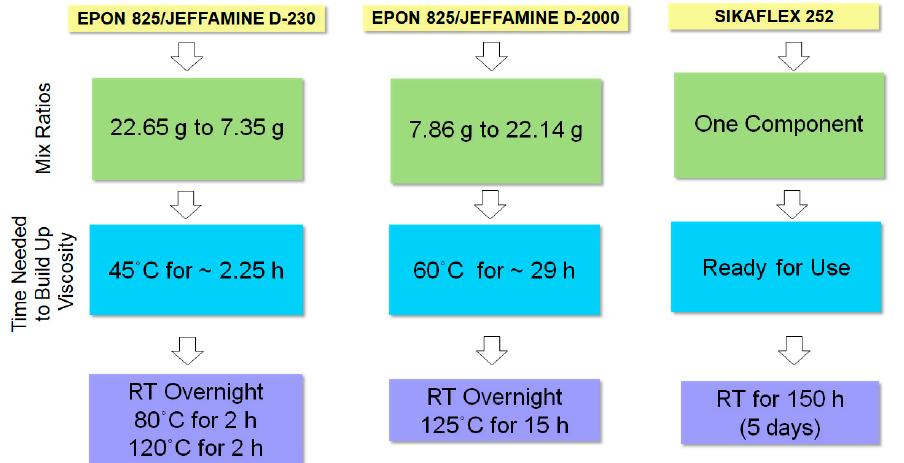
Figure 3. Preparation procedures of the three different types of adhesives: EPON 825/JEFFAMINE D-230, EPON 825/JEFFAMINE D-2000, and Sikaflex 252. RT = room temperature.